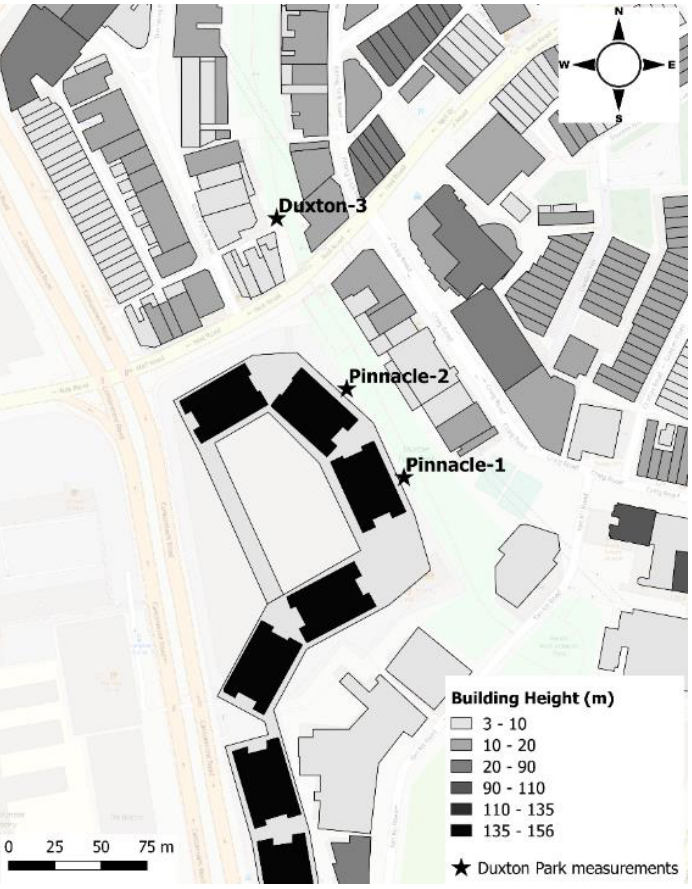
Figure 3. Location of the selected sites for the measurement campaign in the Duxton Park area. Table 1. Description of the sites in the Duxton Park area where measurements were carried out.